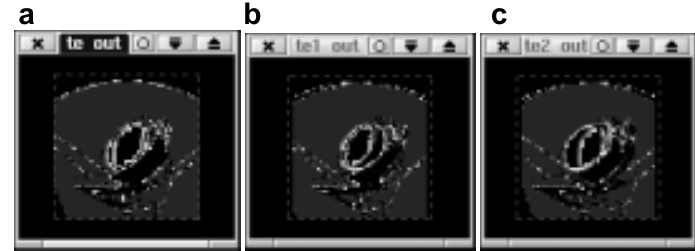
Figure 8 TE (tuned excitatory) filter output images. (a) Output image with displacement parameter of zero. (b) Output image with displacement parameter of 2. (c) Output image with displacement parameter of